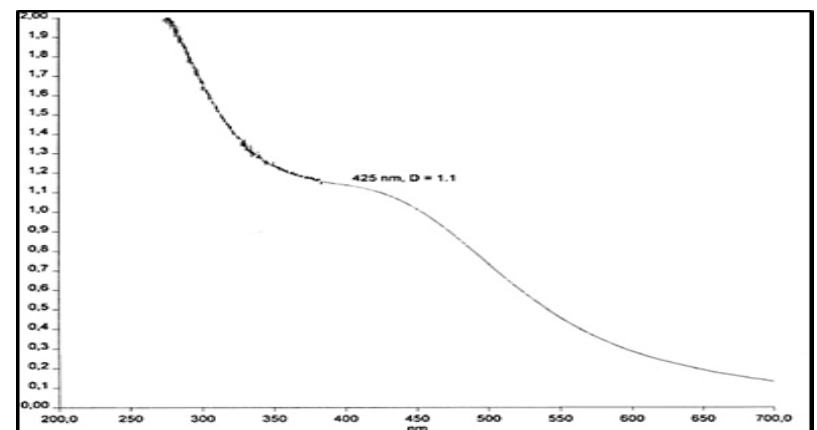
Fig. 2. Electronic spectrum of humic substances isolated from peloid